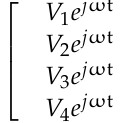
Figure 18. ( a ). Schematic analysis of antenna configuration on the wireless sensor ( b ). CP antenna adaptive analysis of the radiation pattern.